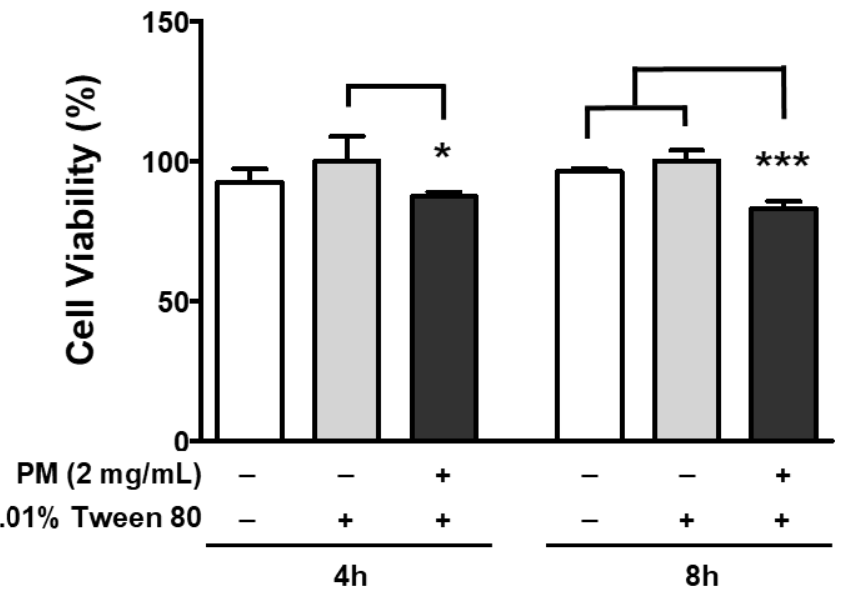
Figure 4. Effect of PM and 0.01% Tween-80 on ARPE-19 cell viability. Cells were treated with 2 mg/mL of PM for 4 or 8 h and viability was measured by the MTT assay. A concentration of 0.01% Tween-80 was used as a vehicle control. The relative ratios to vehicle control are presented as per- centages. Data are portrayed as mean ± SD ( n = 5). Data were analyzed using one-way ANOVA followed by Tukey’s multiple comparison (* p < 0.05, *** p < 0.001). PM; particulate matter, MTT; 3-